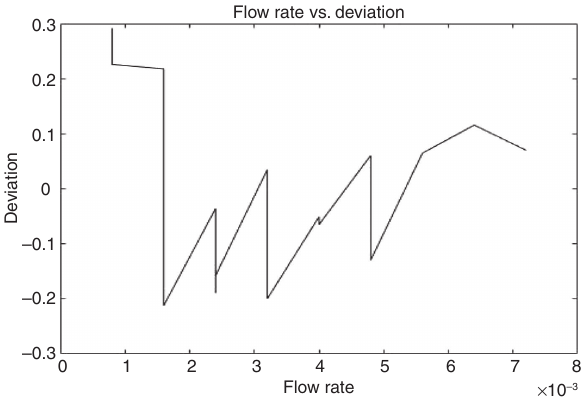
Figure 5: Deviation vs. Experimental Flow